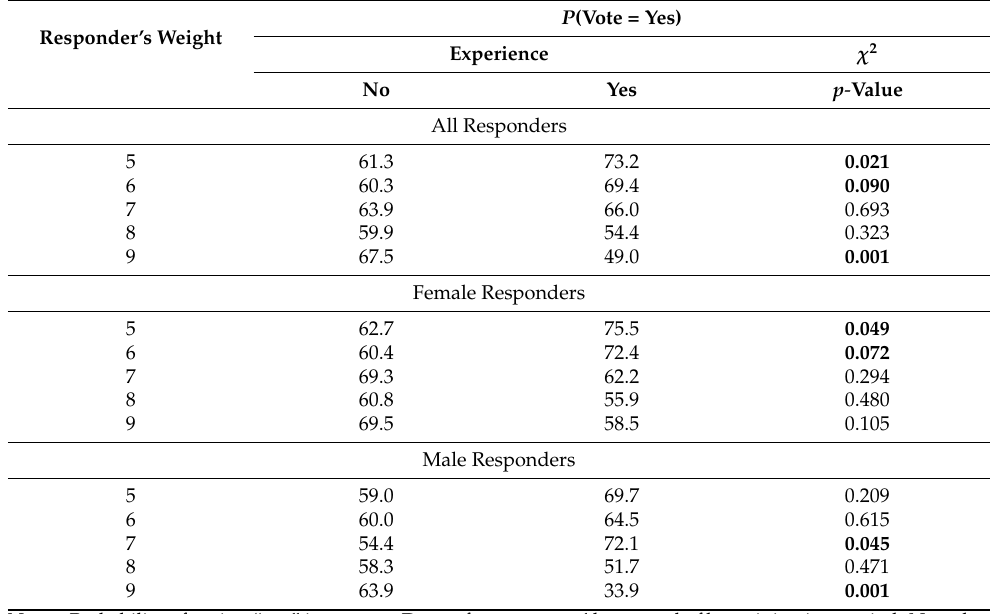
Table A4. Responders’ Probability to Vote “Yes” by Gender, Nominal Voting Weight and Experience.